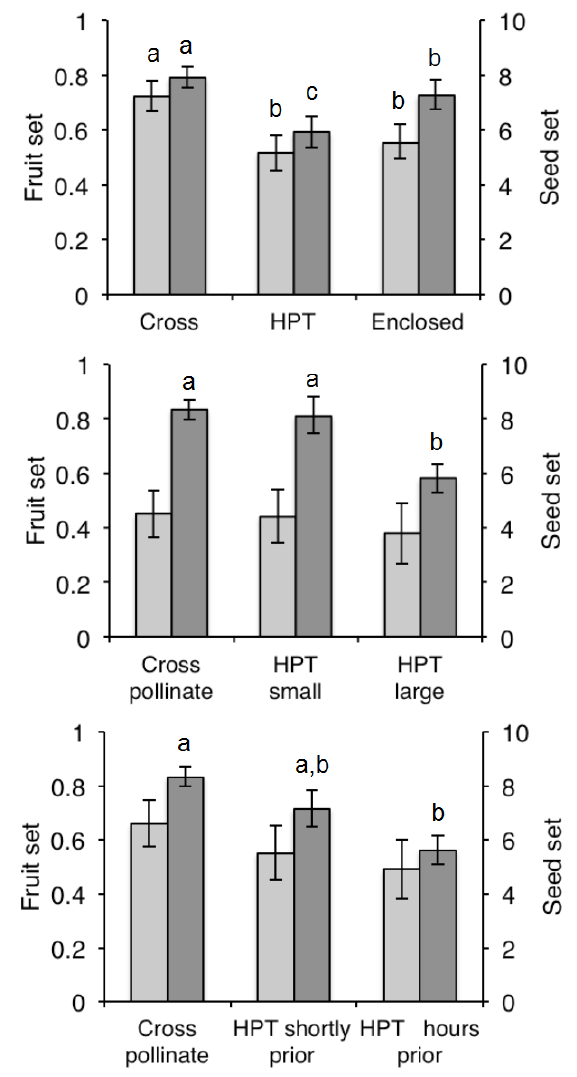
F IGURE 1. Mean (± SE) fruit set (light bars) and seed set (dark bars) for Linum rigidum flowers in field enclosures that were exposed to various pollination treatments. (A) 2005 study in which flowers were cross pollinated (Cross), exposed to heterospecific pollen transfer from Euphorbia esula then cross pollinated (HPT), or left without manipulation (Enclosed); (B) 2006 study in which flowers were cross pollinated (Cross pollinate), or pollinated with a small (HPT small) or large (HPT large) quantity of E. esula pollen, then cross pollinated 2 – 4 hours later; (C) 2006 study in which flowers were cross pollinated, pollinated with a large quantity of E. esula pollen then cross pollinated soon thereafter (HPT-shortly- prior), or cross pollinated 2 – 4 hours later (HPT-hours-prior). Different letters above bars indicate a significant difference among